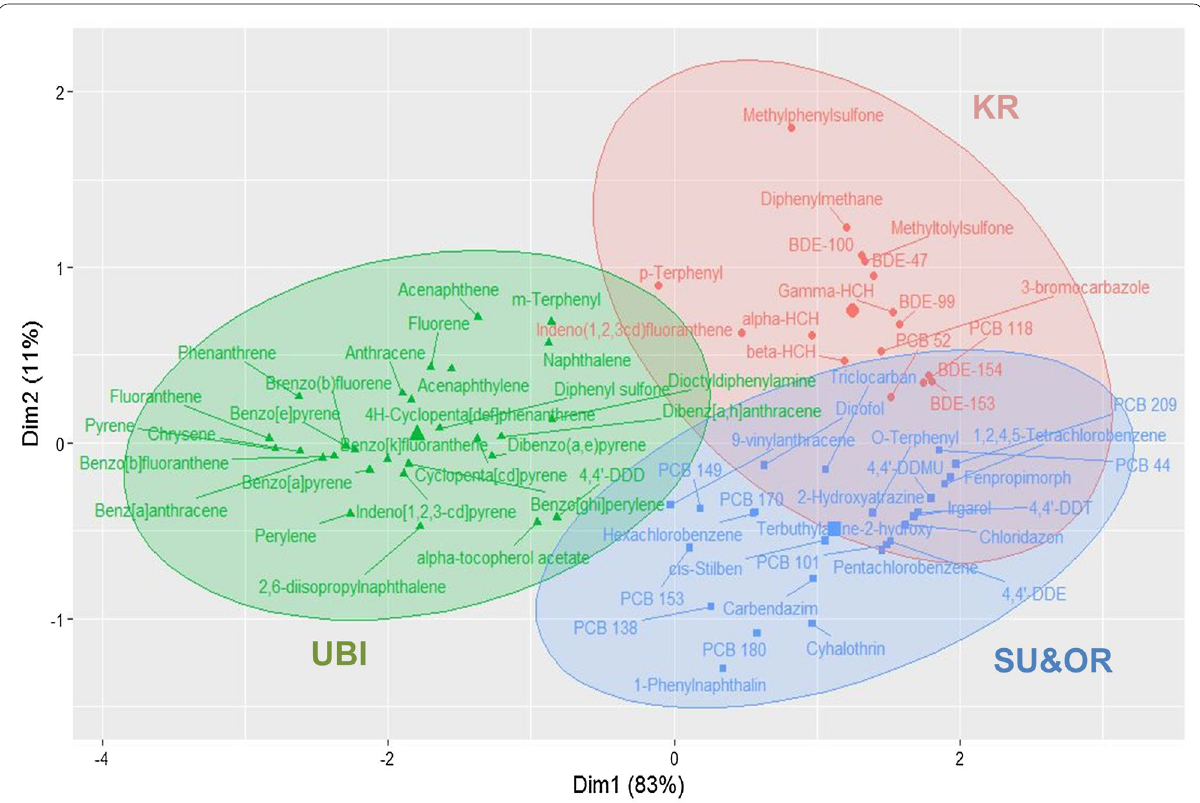
Fig. 1 K-means cluster of 71 detected organic chemicals (UBI: Ubiquitous; KR: Specific in Kramfors; SU&OR: Specific for Sundsvall and Örnsköldsvik). Data were log normalized and centered before analysis (Normal probability inorganic chemicals by k-means cluster analyses (data not